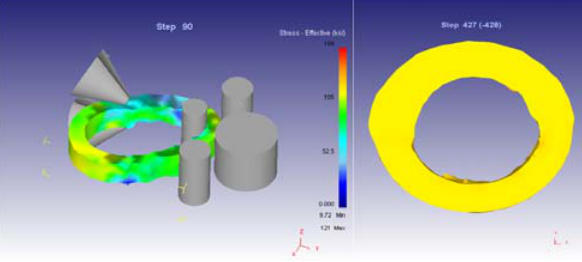
Fig. 1. R rolling System configuration and ring part with defects